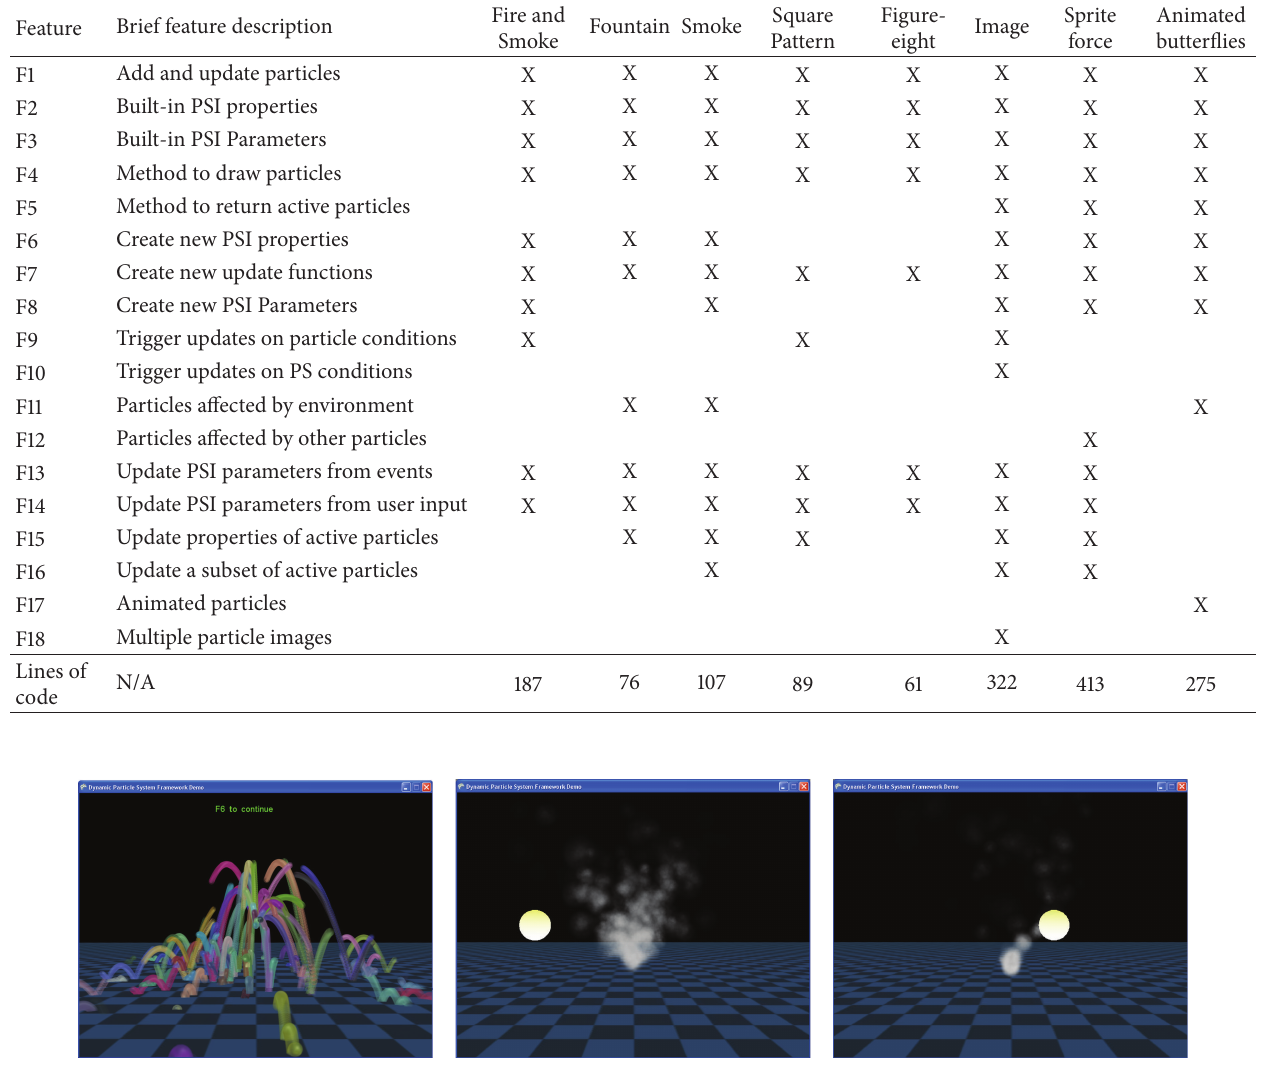
Figure 2: Two effects showing interaction with the virtual environment.